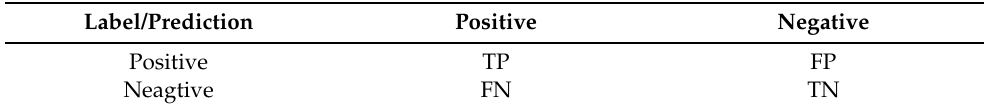
Table 1. Matrix of classification metrics.